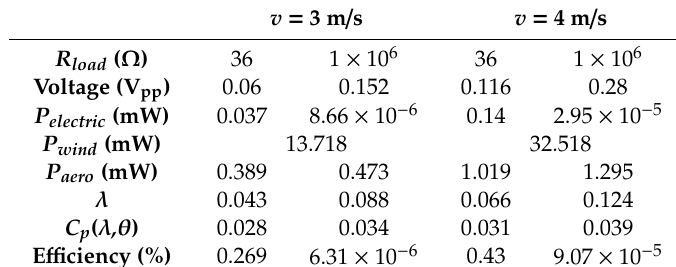
Table 8. Open space test to verify harvester operation mode.